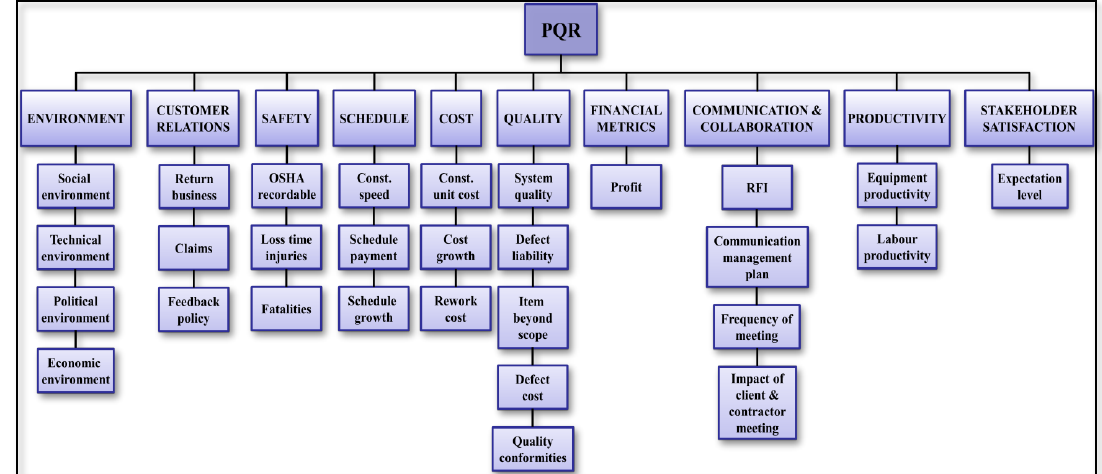
Figure 2. Modified PQR